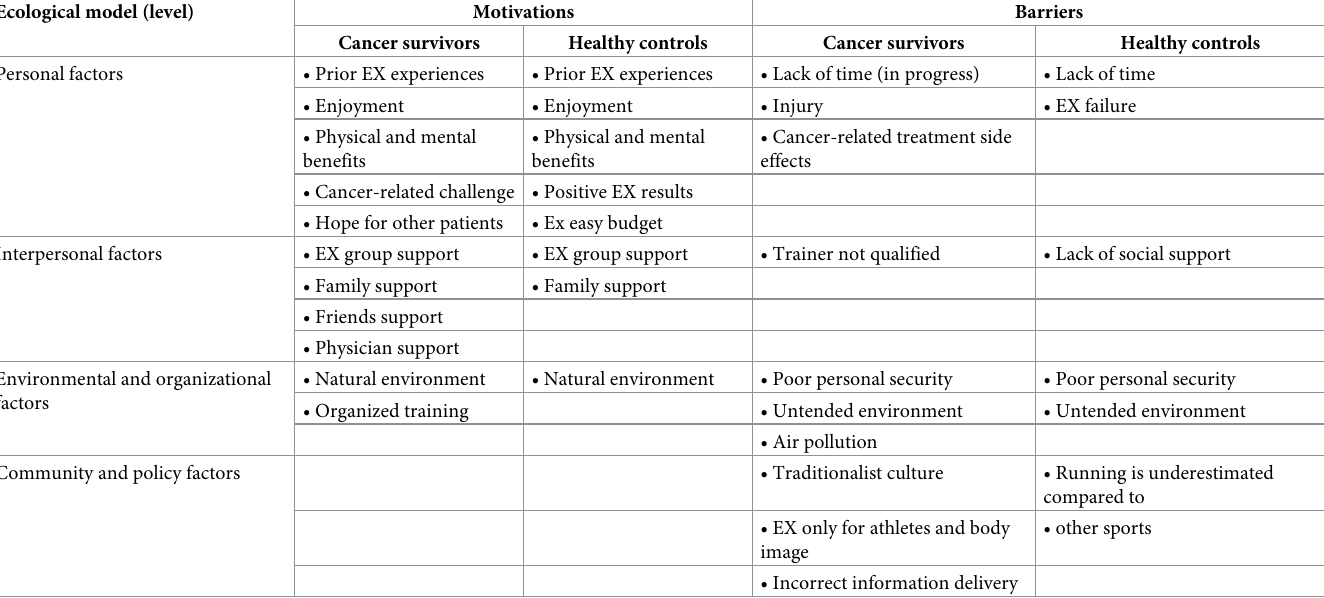
Table 3. Motivation and barriers related to running EX identified by cancer survivors compared to healthy controls. Ecological model